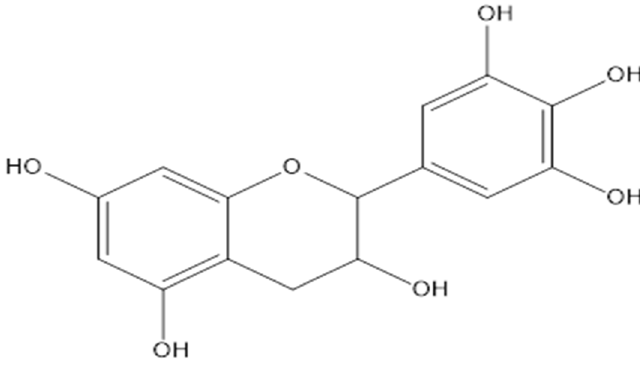
Figure 3. Chemical structure of gallocatechin.